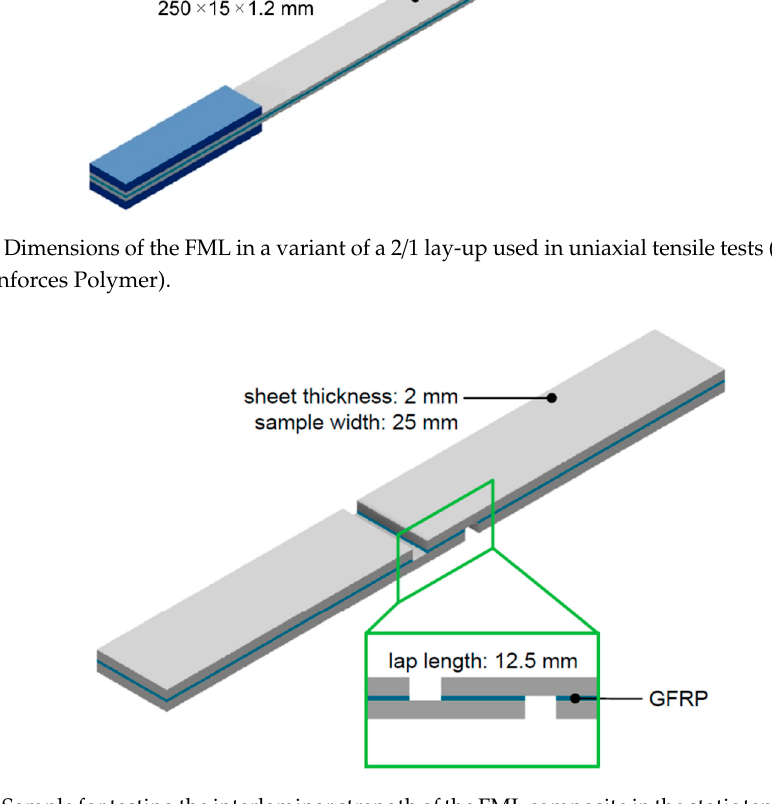
Figure 5. Dimensions of the FML in a variant of a 2/1 lay-up used in uniaxial tensile tests (GFRP – Glass Fibre Reinforces Polymer).